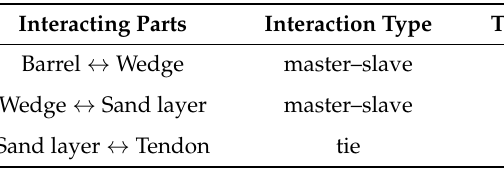
Table 6. Description of the interactions in the model.